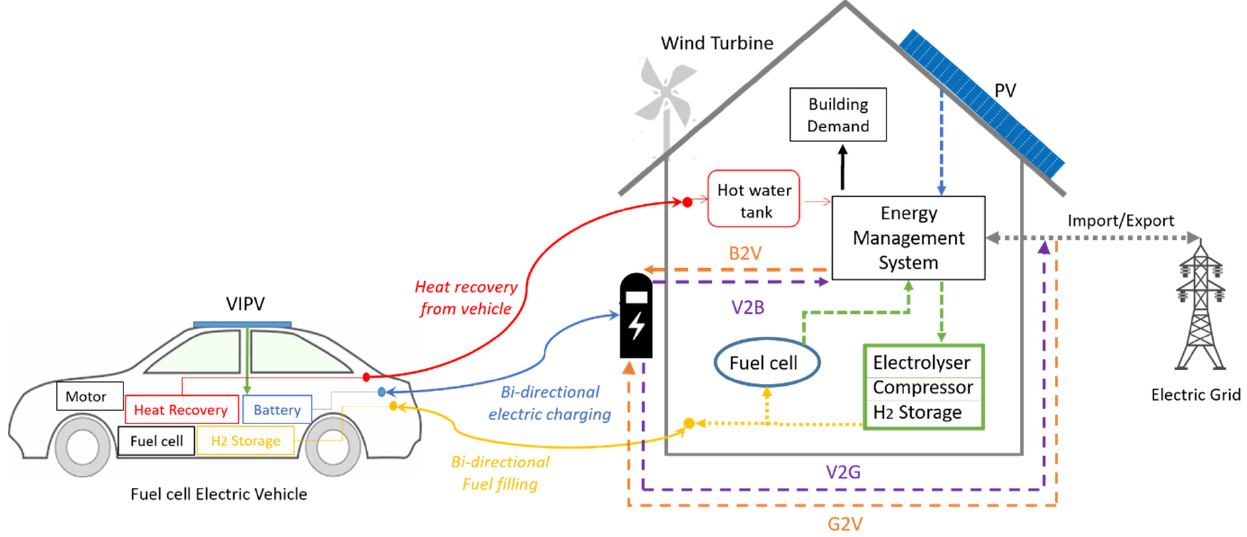
Figure 11. B2V, V2B, V2G and G2V functions of fuel cell electric vehicle parked at a building.